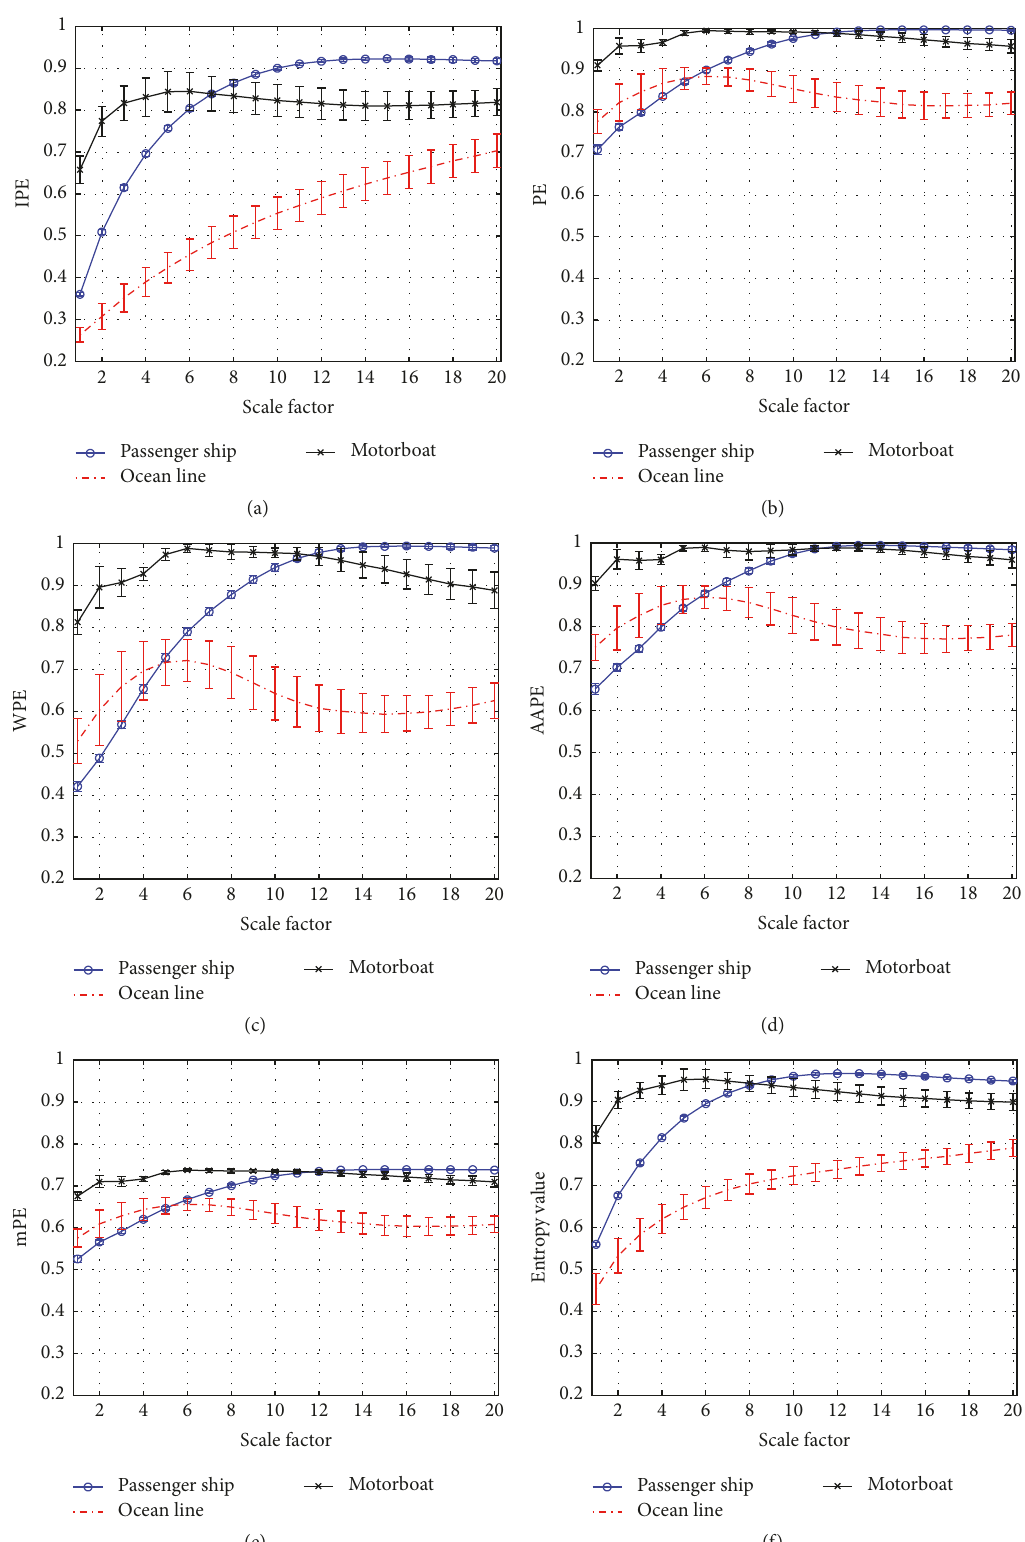
Figure 9: Entropy analysis of three types of ship-radiated noise. (a) Result of IPE. (b) Result of PE. (c) Result of WPE. (d) Result of AAPE. (e) Result of mPE. (f) Result of